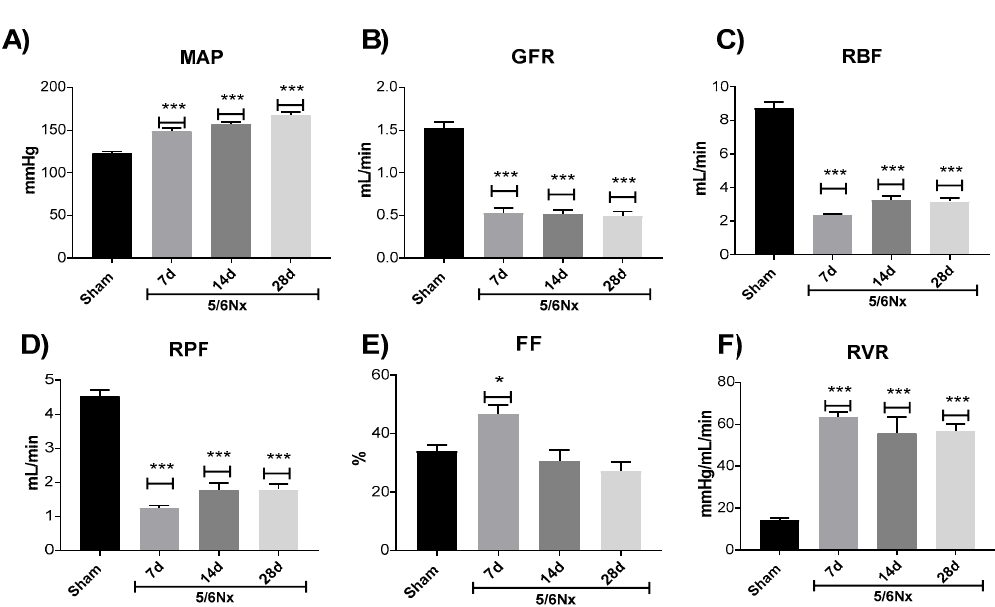
Figure 2. Chronic renal damage induced by 5 / 6 nephrectomy (5 / 6Nx). Temporal evaluation of hemodynamic parameters: ( A ) mean arterial pressure (MAP), ( B ) glomerular filtration rate (GFR), ( C ) renal blood flow (RBF), ( D ) renal plasma flow (RPF), ( E ) filtration fraction (FF), ( F ) renal vascular resistance (RVR). Data are mean ± SEM, n = 4–8. * p < 0.05, *** p < 0.001 vs. Sham, Dunnett test. d = days after nephrectomy surgery, Sham = simulated operation-control group.